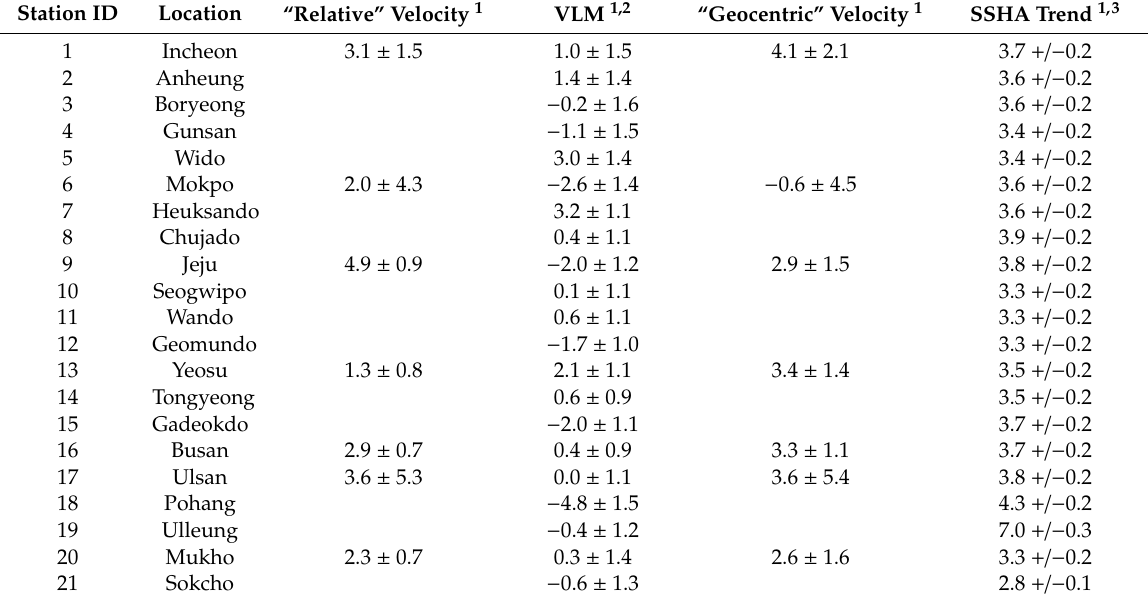
Table 2. Summary of results at each tide gauge in 2019 (mm /